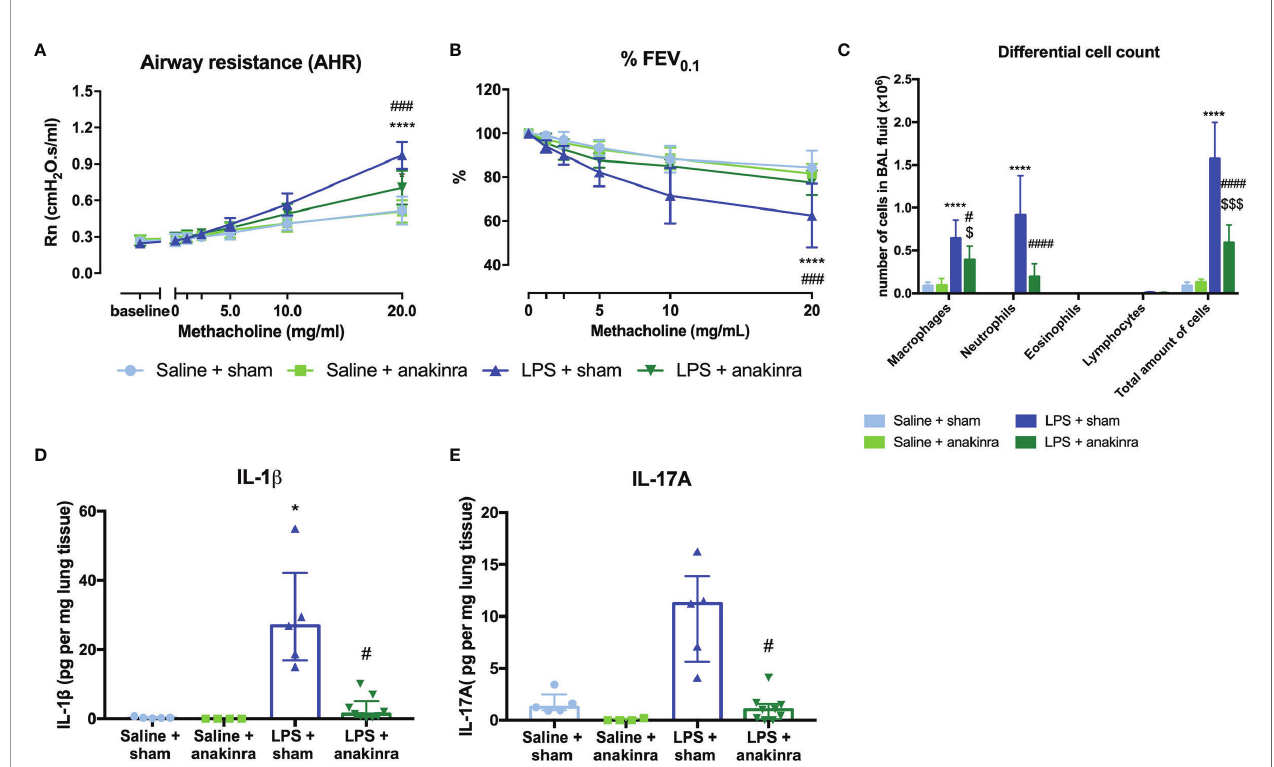
FIGURE 6 | Effect of anakinra in the LPS model. SCID mice were endonasally treated with anakinra (50 m l of a 20 mg/ml solution) on days -1, 1, and 3 together with the four endonasal challenges with LPS (2 µg in 50 µl saline), as shown in Supplementary Figure 1C . Twenty-four hours after the last challenge with LPS, lung function parameters were measured using the FlexiVent, and BAL fl uid was obtained for differential cell count and lung tissue for cytokine analysis. Airway resistance [Rn, (A) ] and FEV 0.1 [%, (B) ] before and after methacholine provocation (0 – 20 mg/ml) were measured in saline + sham-treated mice (n = 7), saline + anakinra-treated mice (n = 7), LPS + sham-treated mice (n = 7) and LPS + anakinra-treated mice (n = 7). Differential cell count in BAL fl uid is shown in (C) . Lung IL-1 b and IL-17A levels corrected for lung weight are shown in (D, E) in the different groups. Data are represented as mean with standard deviation in (A – C) and as individual values with median and interquartile range in (D, E) . Two-way ANOVA was used in (A – C) and Kruskal – Wallis with Dunn ’ s post hoc test was used to calculate the p-values. *p < 0.05; ****p < 0.0001 (saline + sham versus LPS + sham). # p < 0.05; ### p < 0.001; #### p < 0.0001 (LPS + sham versus LPS + anakinra). $ p < 0.05; $$$ p < 0.001 (saline + anakinra versus LPS +